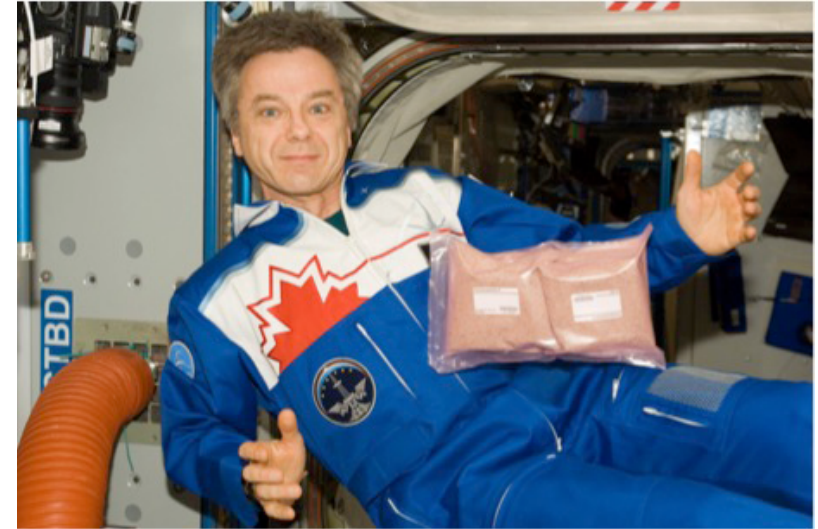
Figure 9: Canadian astronaut, Dr. Robert Thirsk, displaying 1.2 million tomato seeds aboard the International Space Station. The seeds were returned to Earth and distributed to nearly 20,000 classrooms as part of the on-going Tomatosphere TM STEM education and outreach